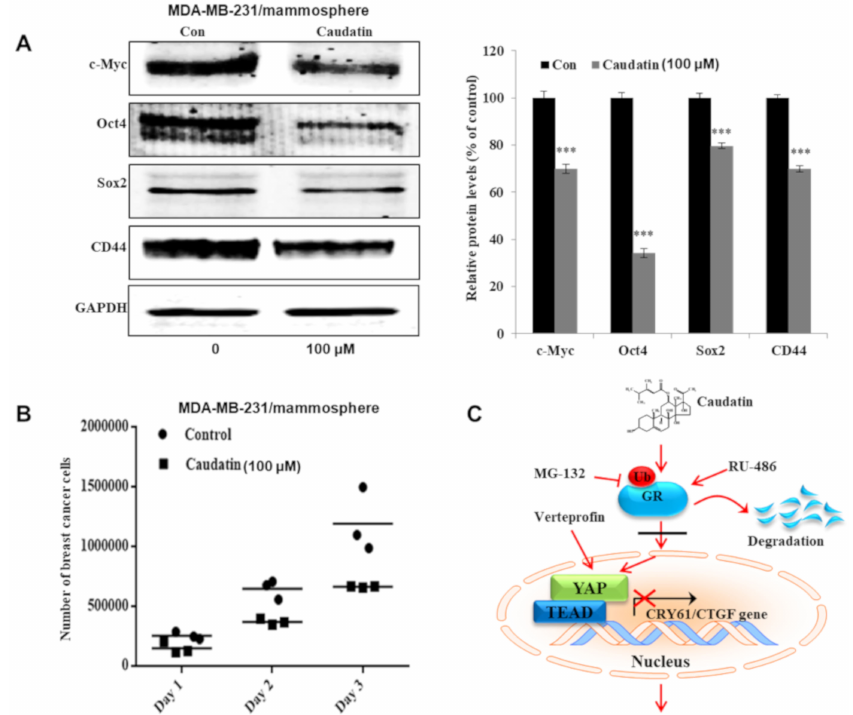
Figure 8. The e ff ects of caudatin on the expression of CSC marker proteins and mammosphere growth. ( A ) Western blot analyses of the c-Myc, Oct4, Sox2 and CD44 proteins in mammospheres after treatment with caudatin. ( B ) Caudatin inhibits mammosphere growth. Mammospheres with / without caudatin treatment were dissociated into single cells and cultured in 6-cm dishes in equal numbers. One, two and three days later, the cells were counted. ( C ) The proposed model of breast CSC death mediated through the GR degradation and YAP signaling pathways induced by caudatin is shown. The data are presented as the mean ± SD of three independent experiments. *** p < 0.001 versus the DMSO-treated control